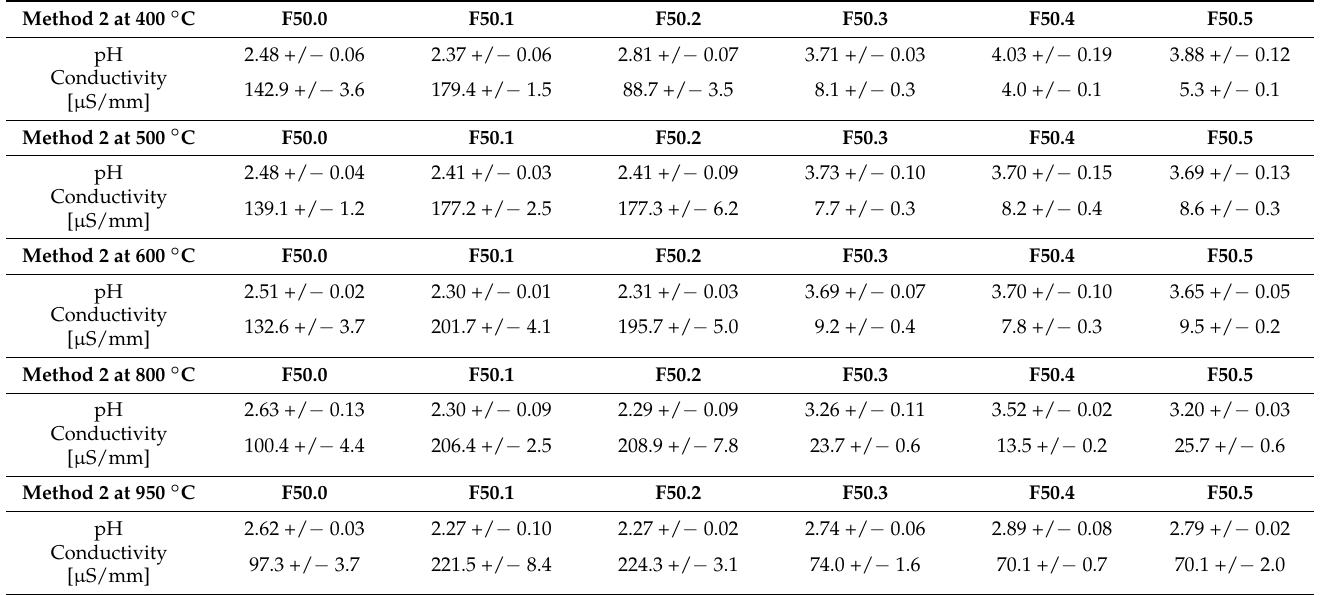
Table 8. Mean values and SD of pH and conductivities at 400 ◦ C, 500 ◦ C, 600 ◦ C, 800 ◦ C, and 900 ◦ C.